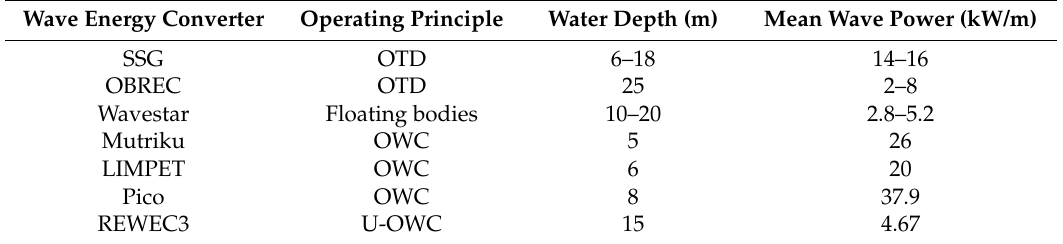
Table 2. Comparison of some WEC technologies. Source: [38] and the Civitavecchia Port